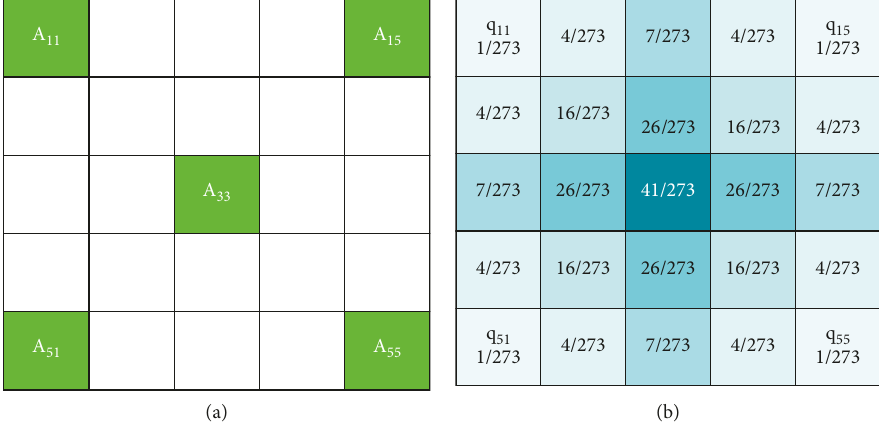
Figure 14: The calculation process of confidence value. Table 4: The confusion matrix of sea-land segmentation.